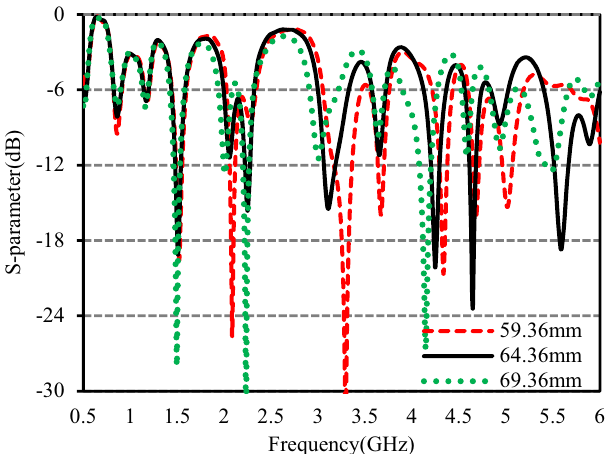
Figure 6. S-parameters for different values of l f .